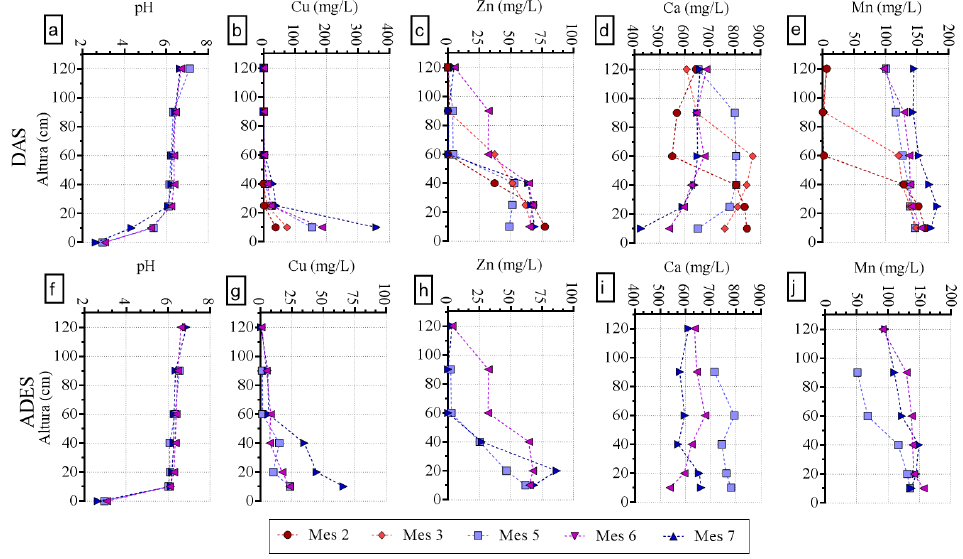
Figure 4. Metal concentration (Cu, Zn, Ca and Mn) profiles for C-DAS ( a – e ) and D-ADES ( f – j ) reactors.